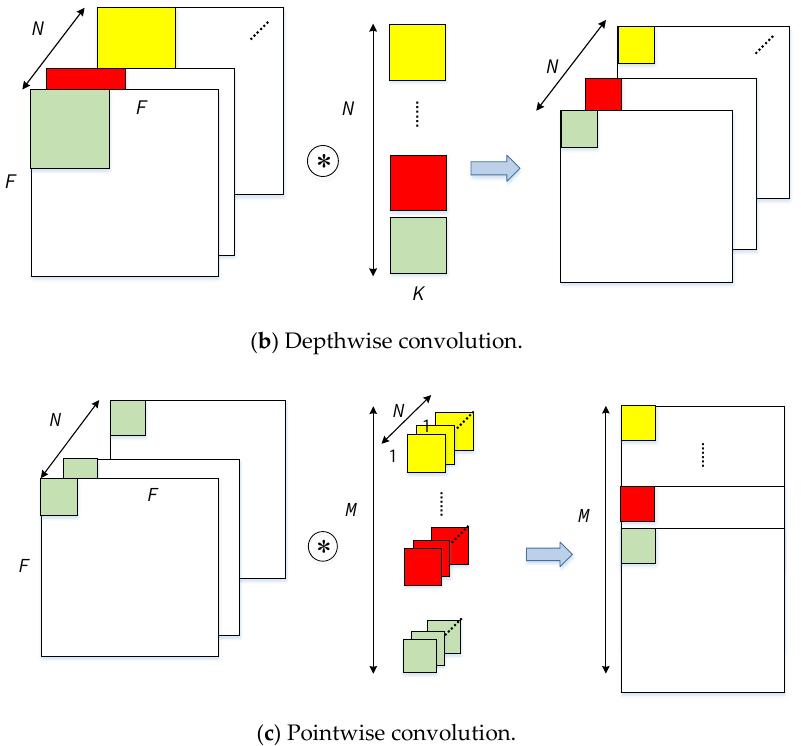
( c ) Pointwise convolution. Figure 2. Standard convolution and depthwise separable convolution. Figure 2. Standard convolution and depthwise separable